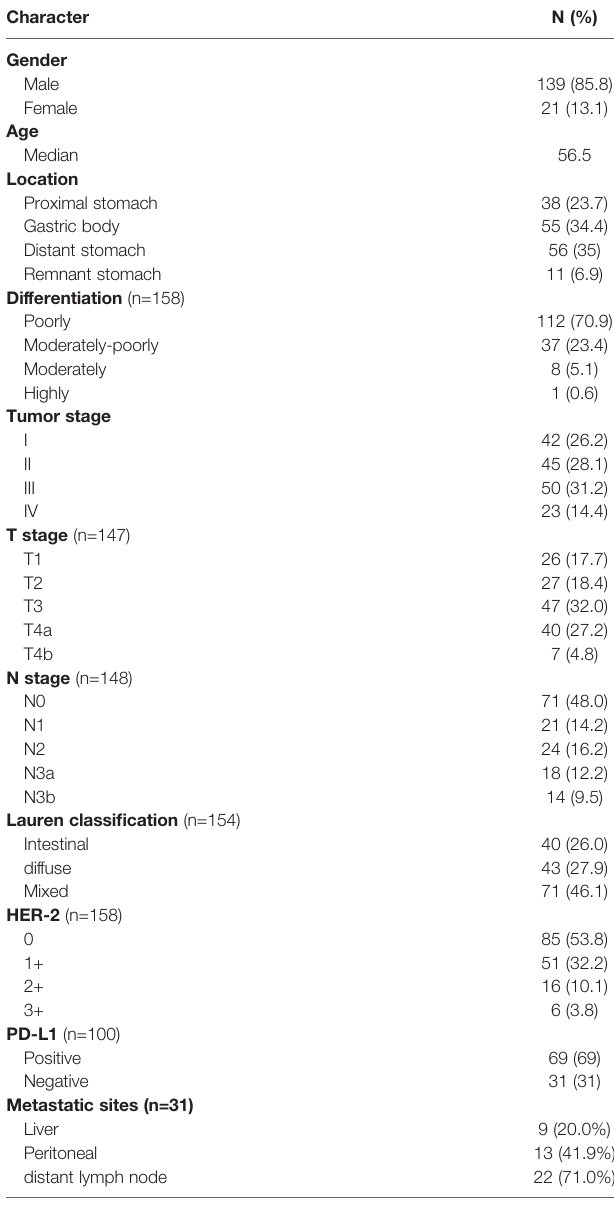
TABLE 1 | Clinicopathological characteristics of